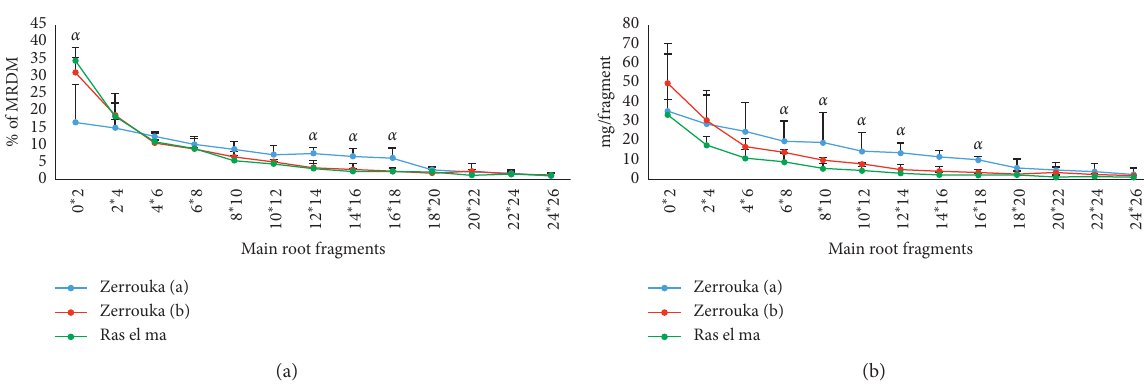
Figure 3: Distribution of main root dry mass without secondary roots in the fragments. (a) Dry mass in % of all the main root dry mass (MRDM). (b) Dry mass in mg/fragment. 0 ∗ 2 means fragment 0 to 2cm. The values marked with α indicate at least one significant difference at the fragment level ( P < 0 . 05, n �